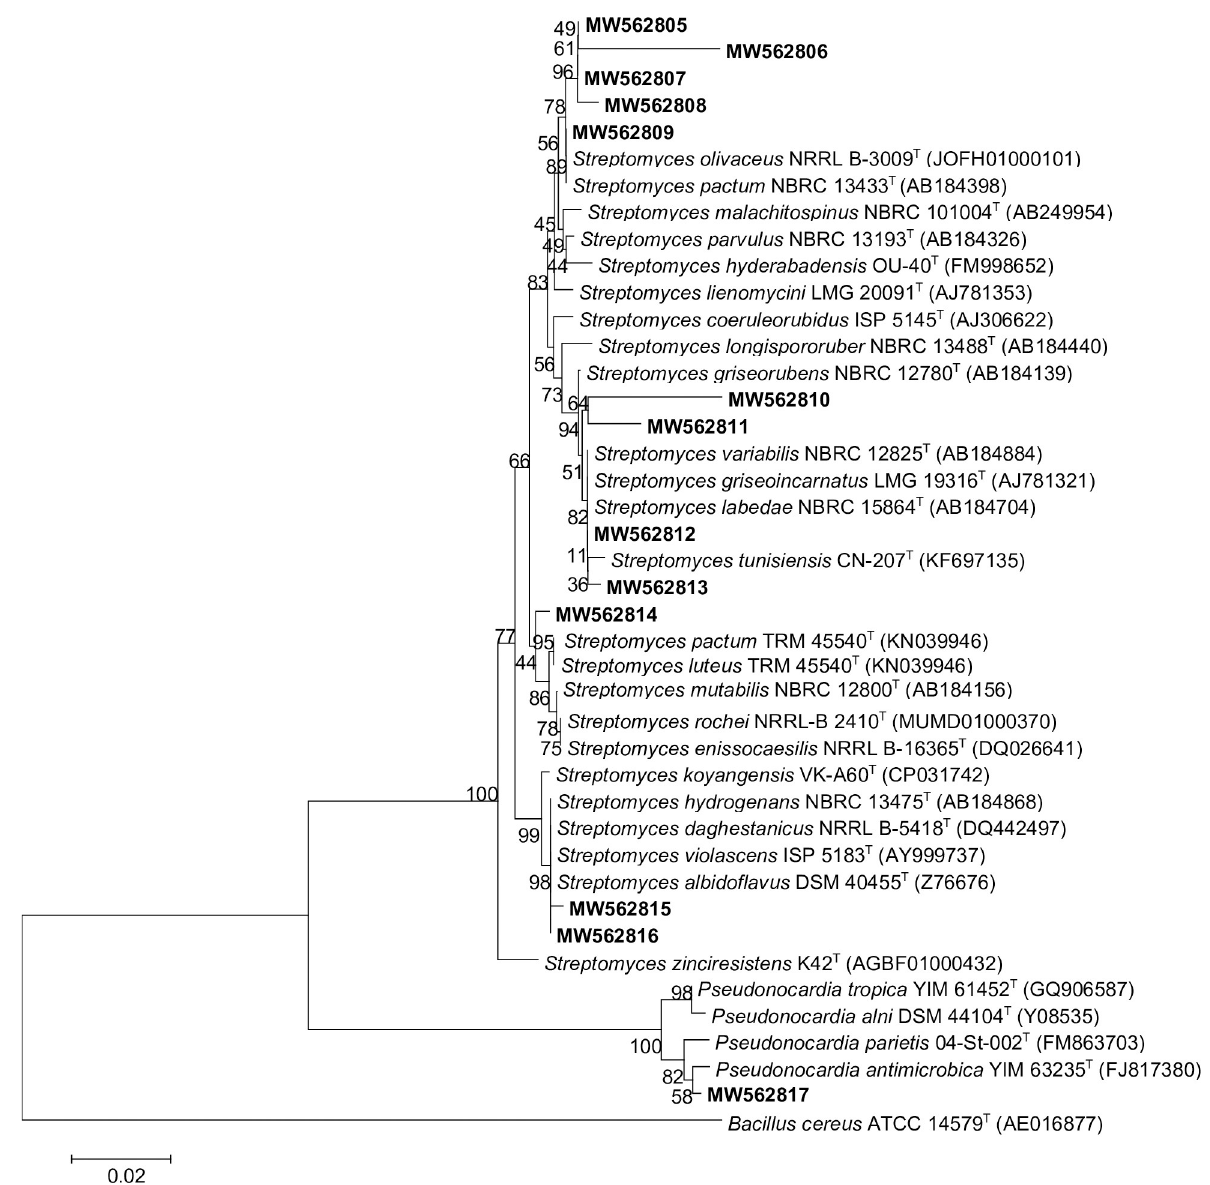
Fig 2. Phylogenetic tree based on 16S rRNA gene sequences (1206–1500 bp positions in the final dataset) inferred using the neighbor-joining method in MEGA7, the evolutionary distances were computed using the Kimura 2-parameter method, showing the phylogenetic positions of different saline isolates and type strains within the Streptomyces and Pseudonocardia genera. Numbers at branching points refer to percentages of bootstrap values from 1000 replicates. Bar, 0.02 substitutions per nucleotide position was used. Bacillus cereus ATCC 14579 T (AE016877) was the